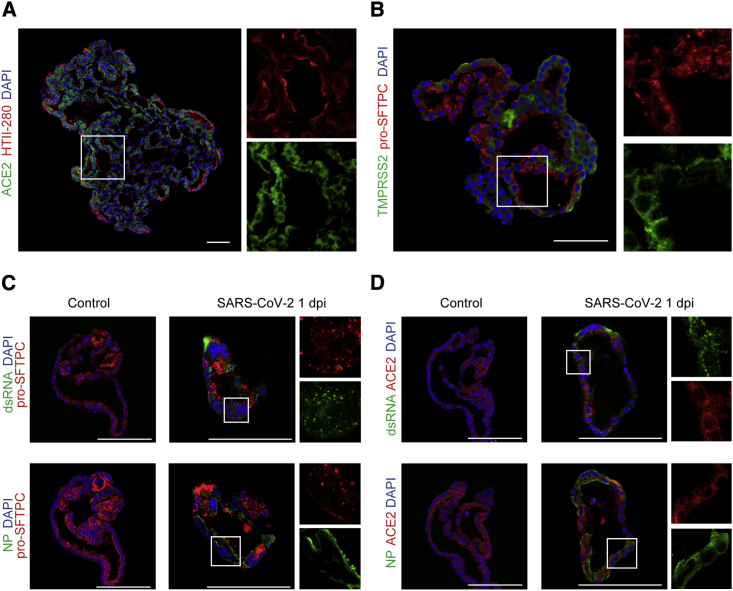
Confocal Imaging of SARS-CoV-2-Infected h3ACs(A) Representative image of IF staining of ACE2 (green) and HTII-280 (red) in h3ACs. All replicates (n = 5 at passage 1–2 from three donors) of control h3ACs express ACE2 and HTII-280. Scale bar, 50 μm.(B) Representative image of IF staining of TMPRSS2 (green) and pro-SFTPC (red) in h3ACs. All replicates (n = 5 at passage 1–2 from three donors) of control h3ACs express TMPRSS2 and pro-SFTPC. Scale bar, 50 μm.(C) Representative images of an infected h3AC at 1 dpi. Viral components (NP or dsRNA; green) are co-stained with pro-SFTPC (red). At 1 dpi, SARS-CoV-2 highly infects h3ACs, which show a punctated pattern of pro-SFTPC. n ≥ 5 replicates of infected h3ACs; P2–P3 from three donors. Scale bar, 50 μm.(D) Representative images of an infected h3AC expressing ACE2 (red). SARS-CoV-2 are identified by viral dsRNA (green) or NP (green). Viral dsRNA appears punctated. n ≥ 5 replicates of infected h3ACs; P2–P3 from three donors. Scale bar, 50 μm.